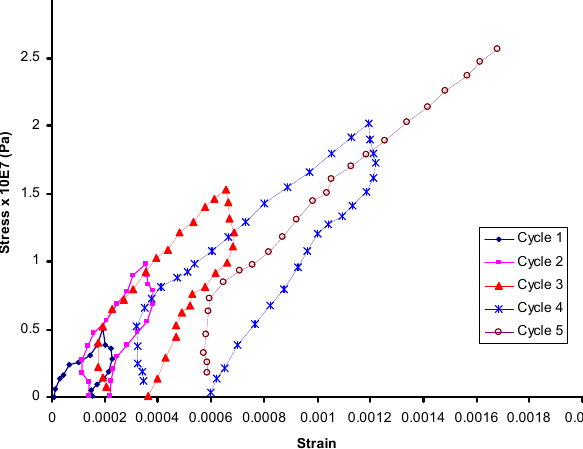
Figure 9. Stress-strain curve determined at a measuring point 60 cm below the loading plate.